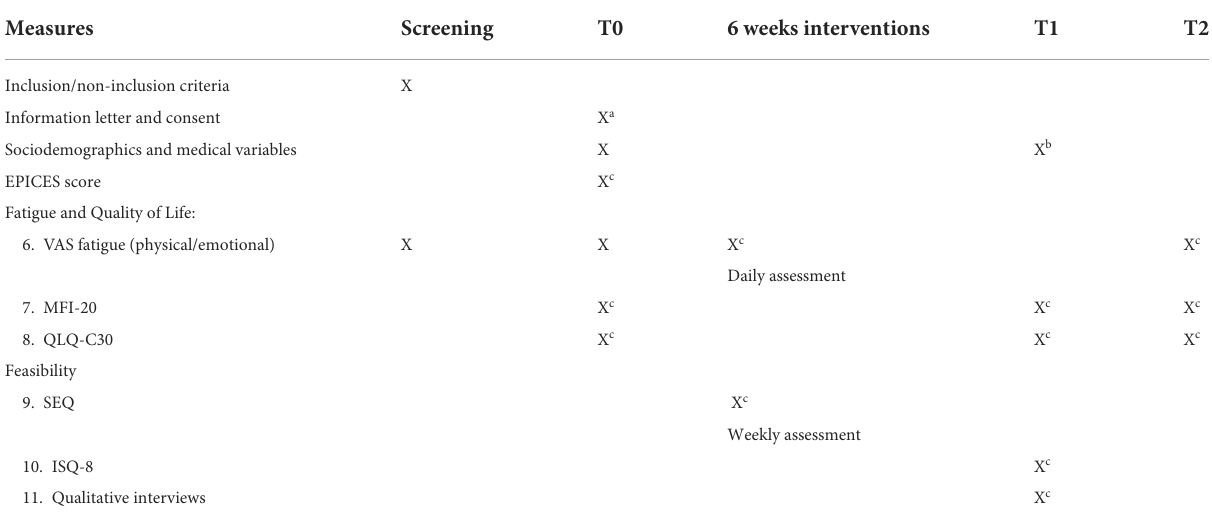
TABLE 2 Measurements used in the